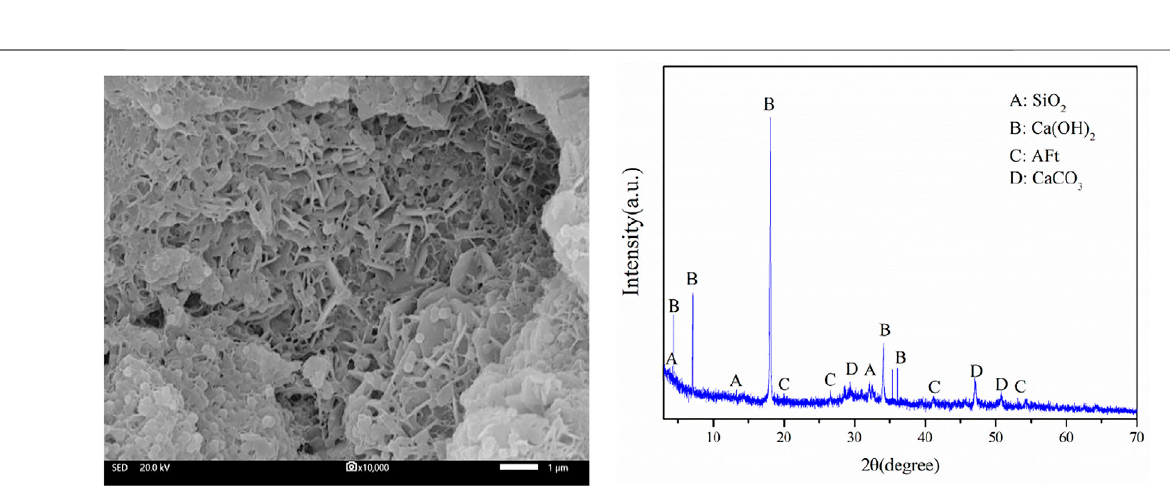
FIGURE 6 | In fl uence of the bentonite dose and emulsi fi ed asphalt dose on the 28-day UCS of CACG.